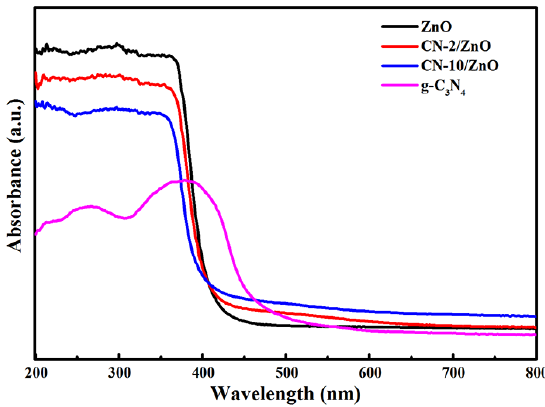
Figure 6. UV-Vis diffuse reflectance spectra of g-C 3 N 4 , ZnO, CN-2/ZnO and CN-10/ZnO photocatalysts.